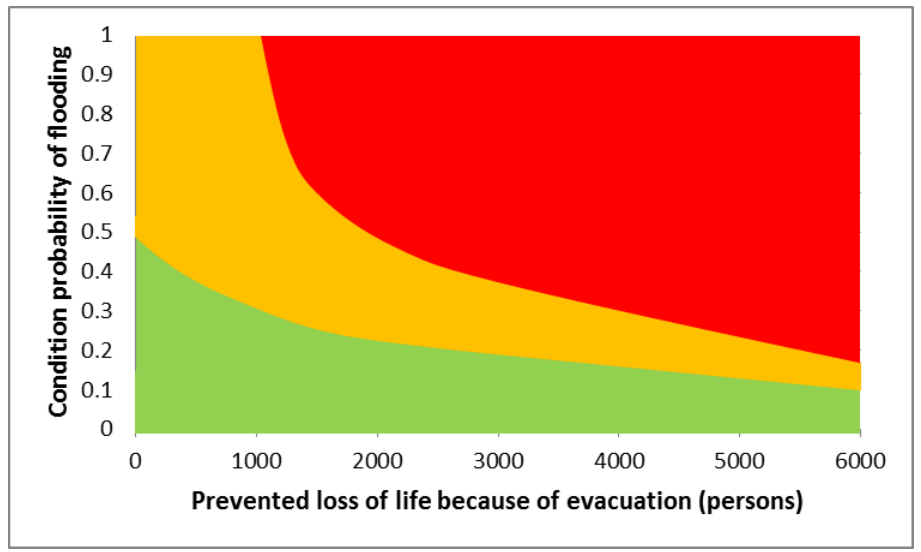
Figure 3. Evacuation diagram for numerical example of the Dutch dike ring no. 14.